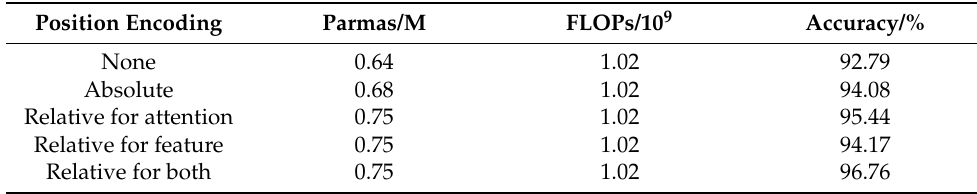
Table 6. Classification accuracy with different Position encoding.